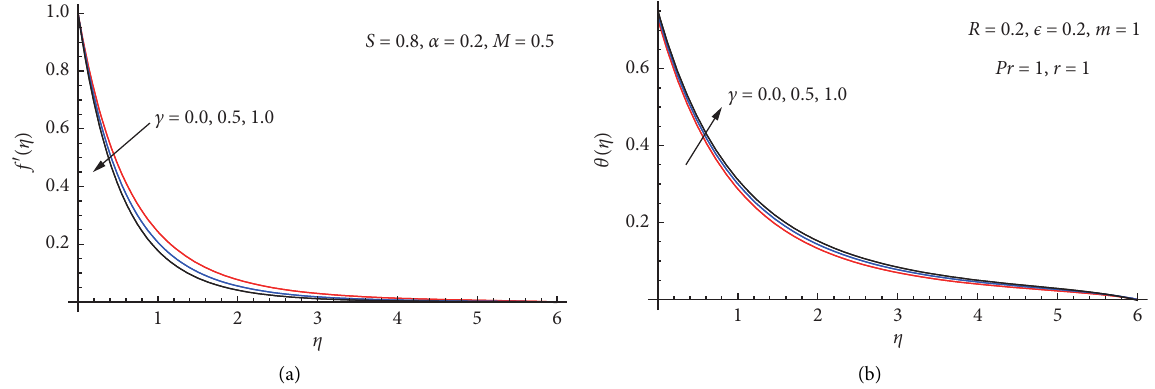
Figure 4: (a) Velocity distribution for c . (b) Temperature distribution for c .